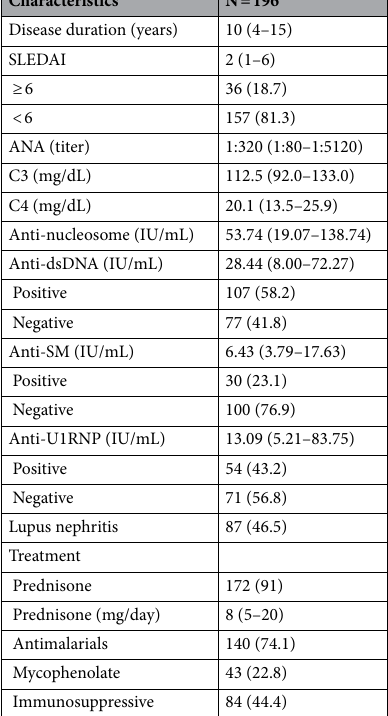
Table 1. Clinical and laboratory parameters of patients with systemic lupus erythematosus (SLE). Data were expressed by median and percentile (25–75%) or absolute number (n) and percentage (%). ANA: semi quantitative values expressed in titers and analyzed as mode. SLEDAI: systemic lupus erythematosus disease activity index; ANA: antinuclear antibodies; C3: complement 3; C4: complement 4; Anti-dsDNA: anti-double- stranded DNA; Anti-SM; anti-Smith; Anti-U1RNP: anti-U1